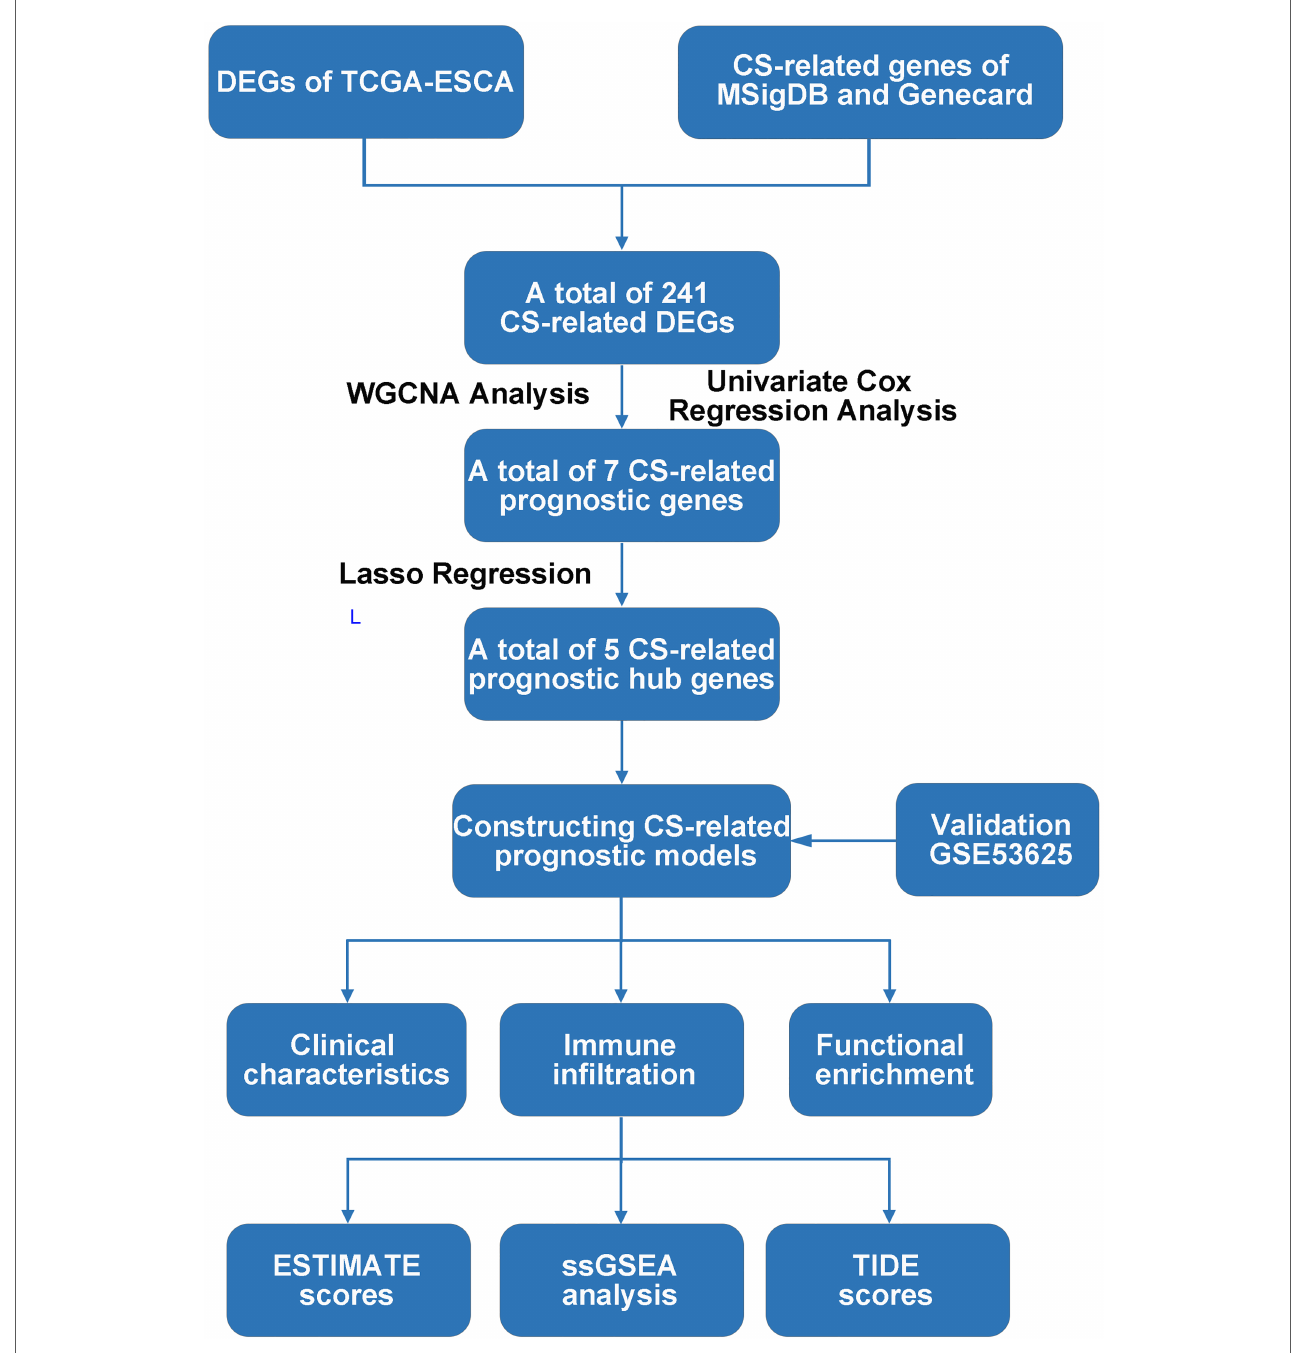
FIGURE 1 Flow chart of the present study. DEG: Differentially expression gene; TCGA, The Cancer Genome Atlas; CS, Cellular senescence; MSigDB, Molecular signatures database; DEGs, Differentially expressed genes; WGCNA, Weighted correlation network analysis; ESTIMATE, Estimation of STromal and Immune cells in MAlignant Tumours using Expression data; ssGSEA, Single sample gene set enrichment analysis; TIDE, Tumor Immune Dysfunction and